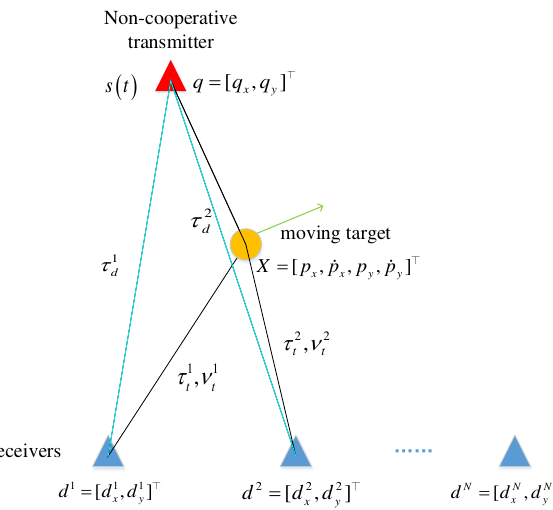
Figure 1. Typical deployment of a